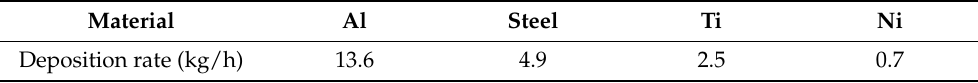
Table 3. The deposition rates of different materials based on AFSD.